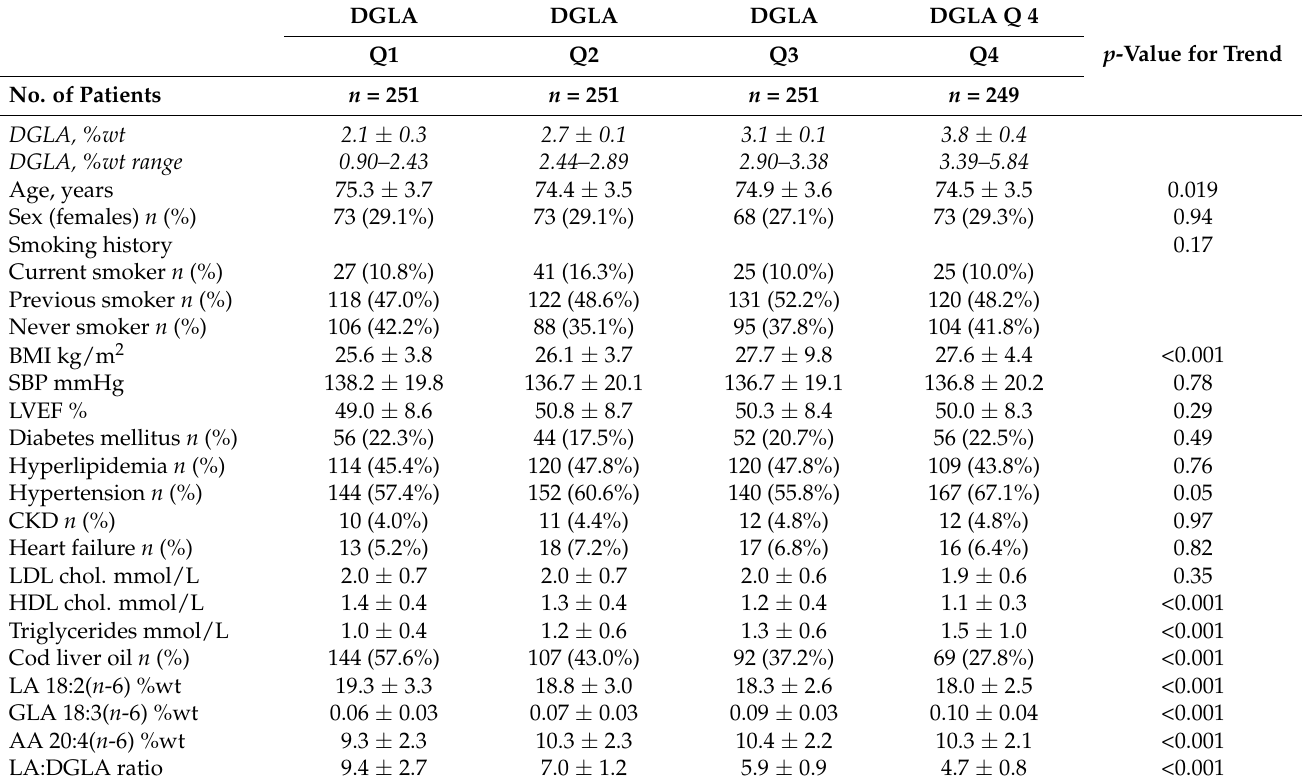
Table 1. Baseline characteristics by serum phospholipid quartiles (Q) of DGLA.